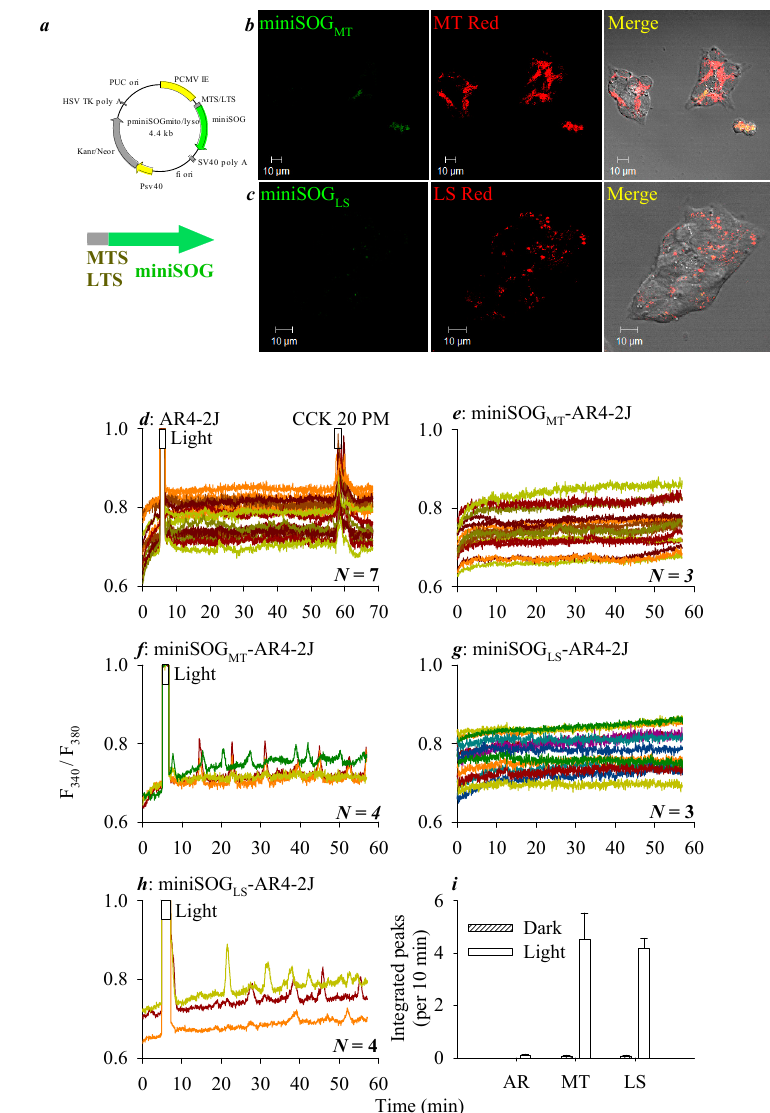
Figure 3. Targeted mitochondrial or lysosomal miniSOG photodynamic action induced persistent calcium oscillations in AR4-2J cells. ( a ) Plasmid pminiSOG MT or pminiSOG LS targeting mitochondria (MT) or lysosomes (LS). miniSOG MT ( b ) or miniSOG LS -AR4-2J cells ( c ) were confocal-imaged 24 h after transfection. miniSOG ( λ ex 488 nm) colocalization with MitoTracker TM Red ( b , λ ex 543 nm) or LysoTracker Red ( c , λ ex 543 nm) were verified, as seen in the merged images. MT Red: MitoTracker Red and LT Red: LysoTracker Red. Scale bars: 10 μ m . Fura-2 AM-loaded AR4-2J ( d ), miniSOG MT -AR4-2J ( e , f ), or miniSOG LS -AR4-2J cells ( g , h ) were perfused; CCK 20 pM or LED illumination (450 nm, 85 mW·cm − 2 , 1.5 min) were applied, as indicated by the horizontal bars. The colored calcium tracings each were from individual cells measured simultaneously from one of N (as indicated) identical experiments, ordinate being fluorescence ratios in F 340 / F 380 and abscissa being time in min, as indicated. LED light irradiation had no effect on baseline calcium in parental AR4-2J cells ( d ). Note that, in the absence of LED light, the baseline calcium concentration remained stable in ( e , g ), but LED light induced persistent calcium oscillations both in miniSOG MT -AR4-2J ( f ) and miniSOG LS -AR4-2J cells ( h ). ( i ) Integrated calcium peaks (per 10 min) in calcium tracings as represented in ( d – h ) were calculated from N experiments. AR: AR4-2J cells as shown in ( d ). MT: miniSOG MT -AR4-2J cells without ( e ) or with ( f ) light. LS: miniSOG LS -AR4-2J cells without ( g ) or with ( h ) LED light irradiation.